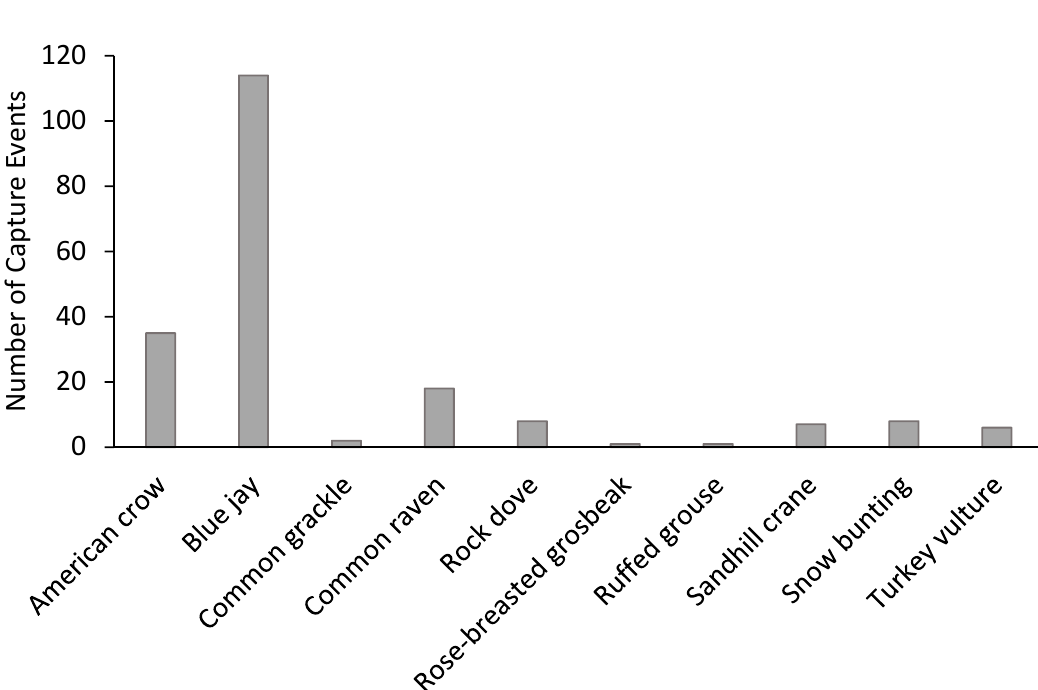
Figure 4. Bird species capture events recorded by cameras on 20 km of the studied railway in one year (2015 to 2016).